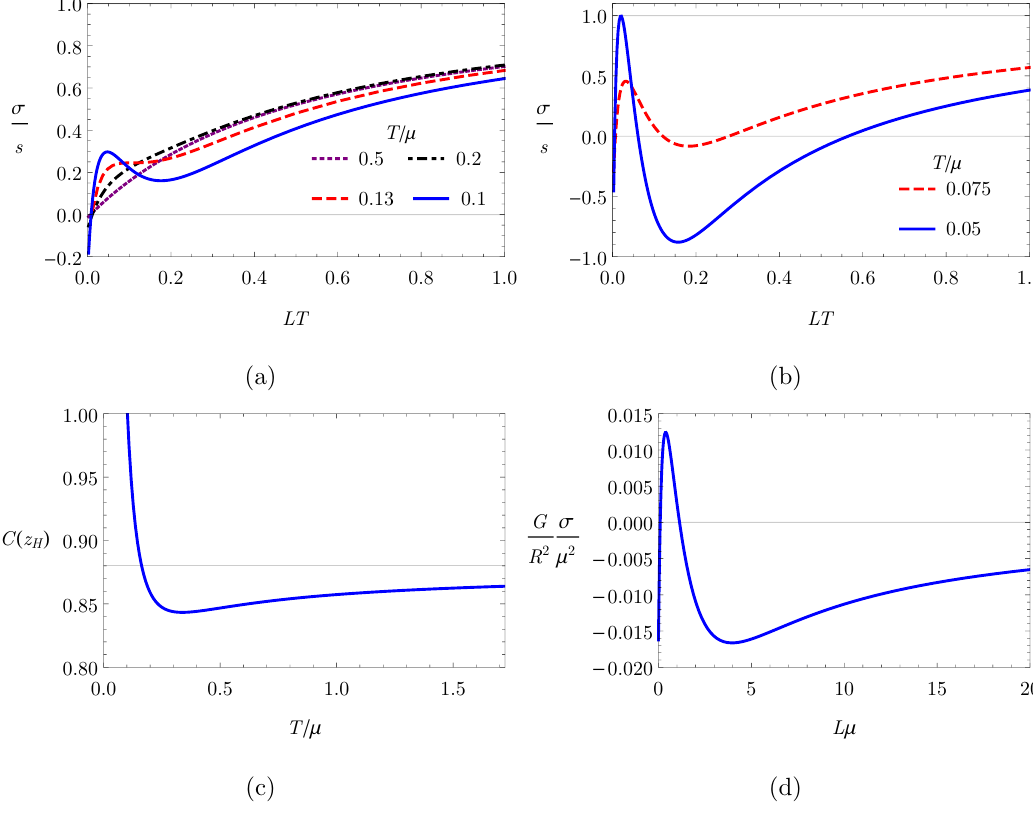
Figure 13. Plots of our results using the solution given by eq. (6.9) ( d = 3, (cid:16) = 2, (cid:18) = (cid:0) 2). (a) The ED, (cid:27) , in units of entropy density s , for the strip, for T=(cid:22) = 0 : 5 down to 0 : 1. A local maximum and minimum appear when T=(cid:22) . 0 : 130. (b) Close-up of (a), but showing the local maximum and minimum’s growth from T=(cid:22) = 0 : 075 down to 0 : 05. (c) The dimensionless coe(cid:14)cient C ( z H ) from eq. (2.23) versus T=(cid:22) . As T=(cid:22) ! 1 , C ( z H ) approaches the value for AdS-SCH with d = 3 (the horizontal line). Clearly C ( z H ) < 0 for all T=(cid:22) , indicating the area theorem is obeyed. (d) The ED, (cid:27) , in units of (cid:22) 2 R 2 =G , versus L(cid:22) , for the strip at T=(cid:22) = 0. The local maximum and minimum remain, and the area theorem is still